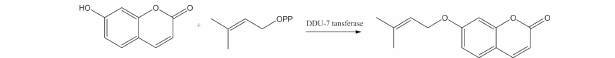
Figure 2. Biosynthetic pathway of 7-isopentenyloxycoumarin in A. majus